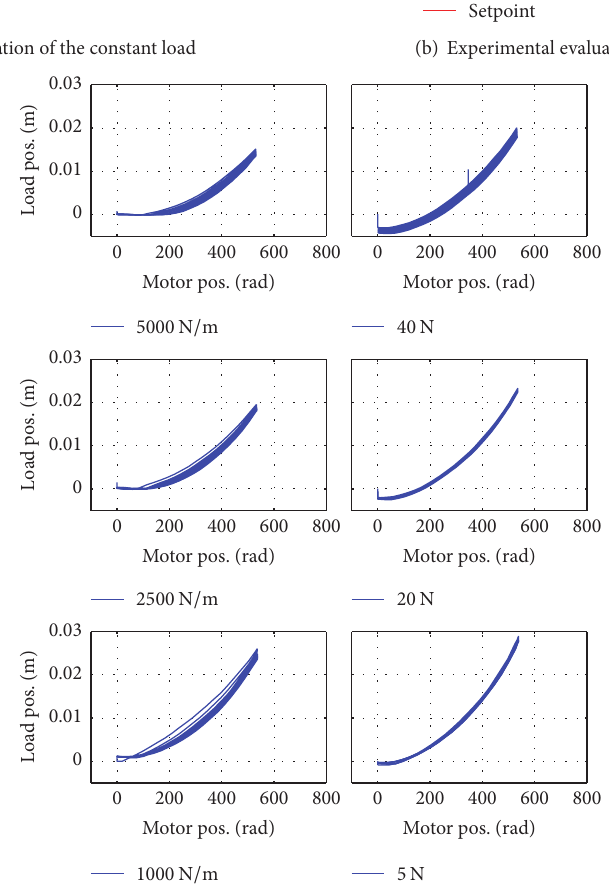
Figure 9: Dynamic response of the TSA actuation